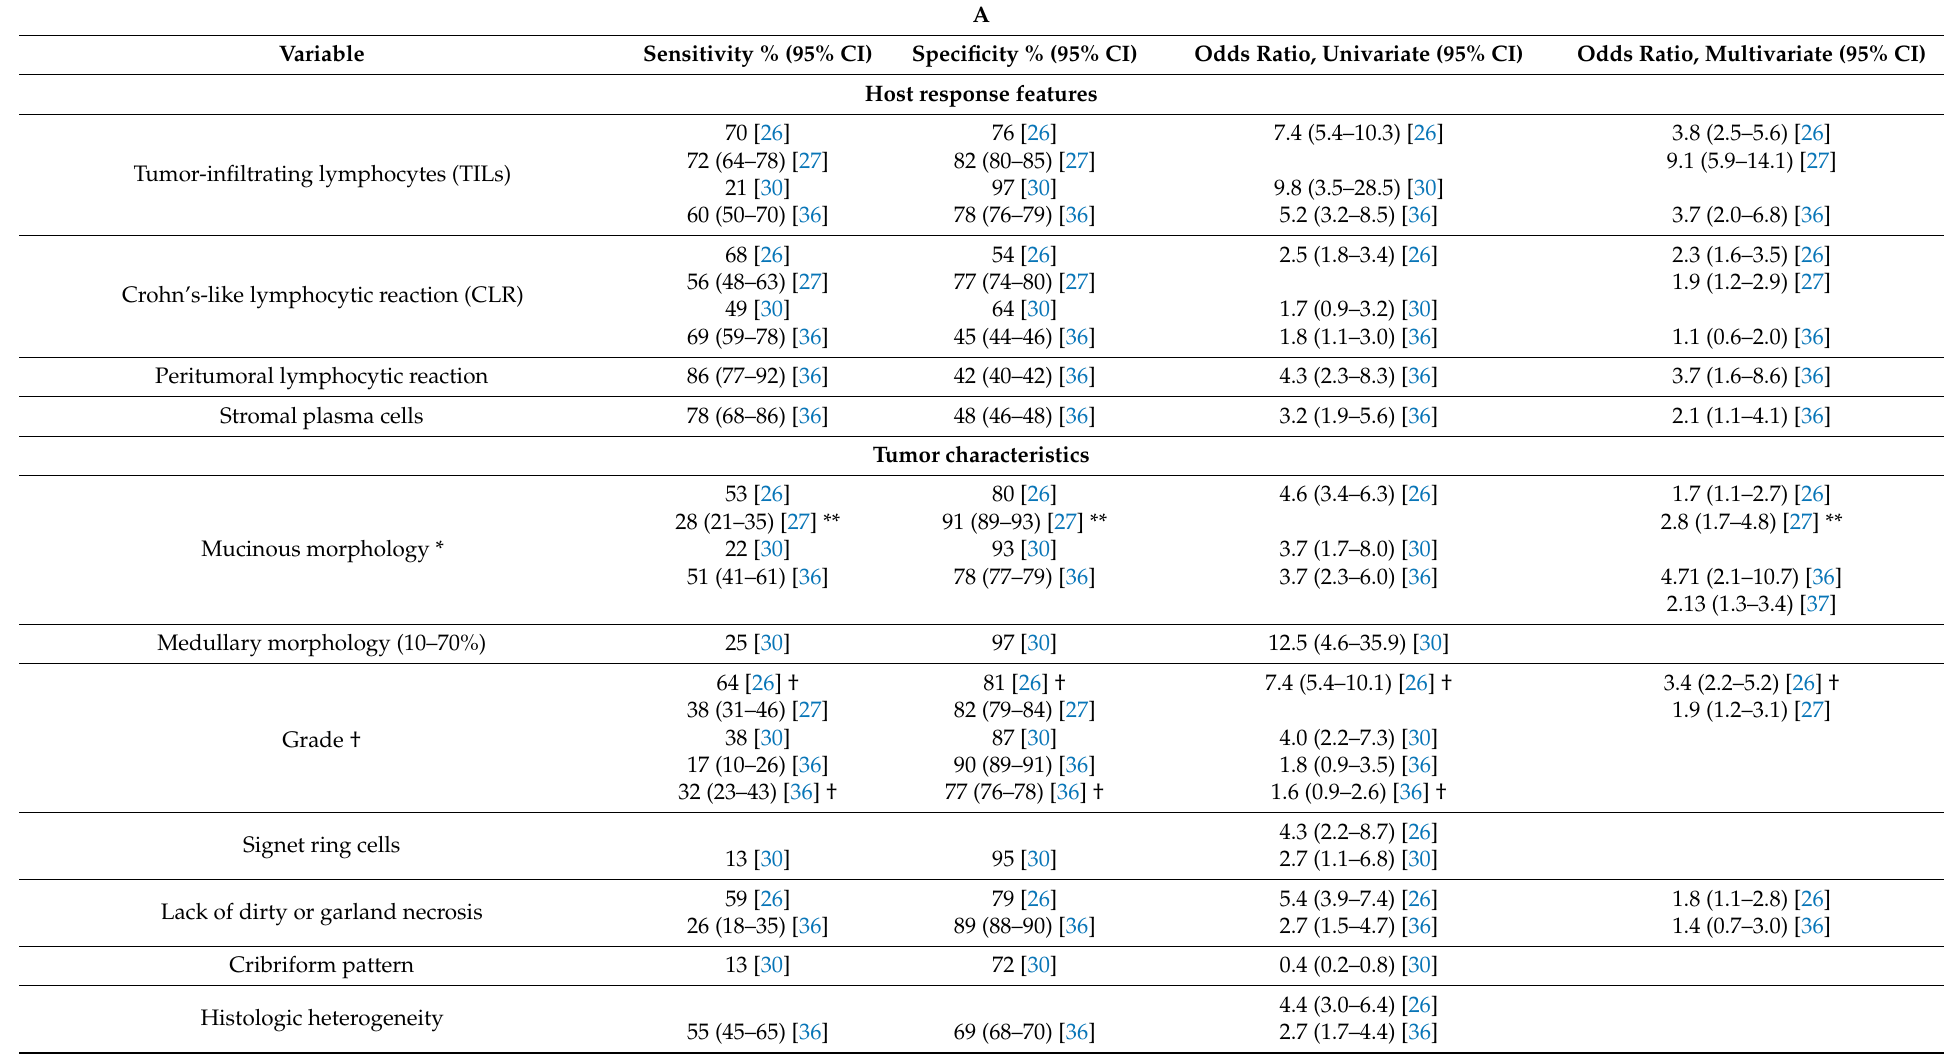
Table 1. Histological predictors of microsatellite